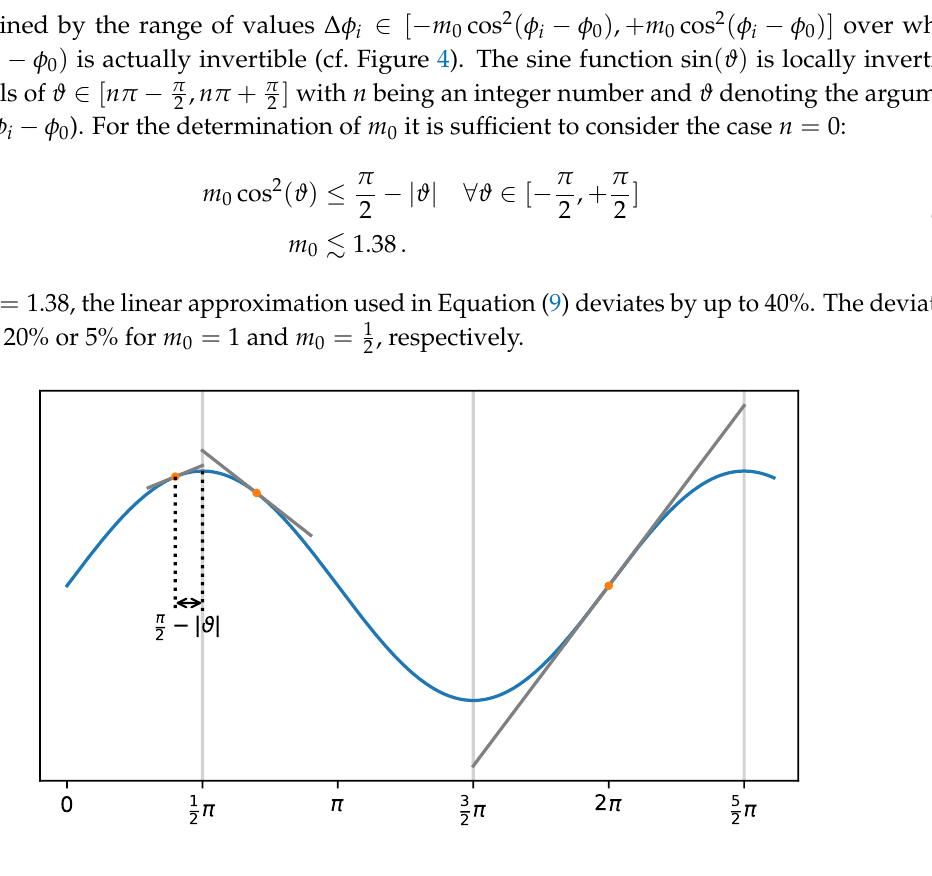
Figure 4. Illustration of the maximal sensible ranges for linear approximations of a sinusoid. Vertical lines at the turning points indicate the boundaries of monotone sections that should never be crossed by linear approximations of the curve. The maximum meaningful range is thus largest for points furthest from these boundaries and reduces to zero exactly at the turning points. Equation (12) approximates this phase dependence of the validity range with a cos 2 function, and Equation (13) defines the maximum amplitude admissible to indeed never exceed turning